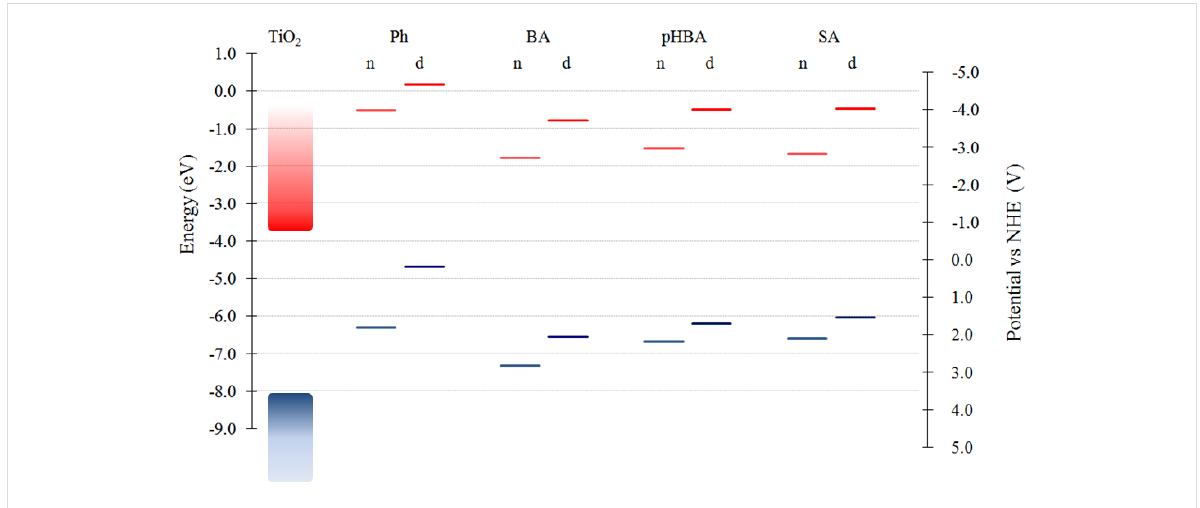
Figure 2: Diagram of energy with respect to vacuum as well as potential versus the normal hydrogen electrode (NHE) of pollutants in both neutral and deprotonated forms, calculated at DFT/B3LYP/TZVP level in solution. In the case of pHBA and SA the deprotonation is on the carboxy group.